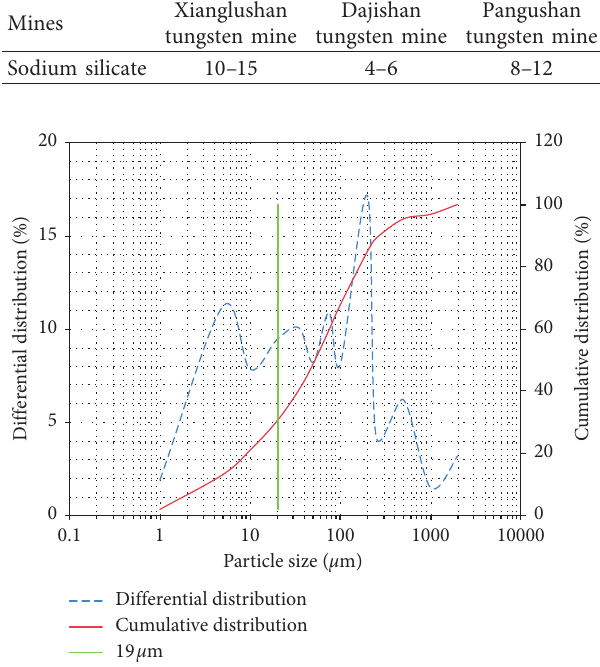
Figure 2: Particle size distribution of